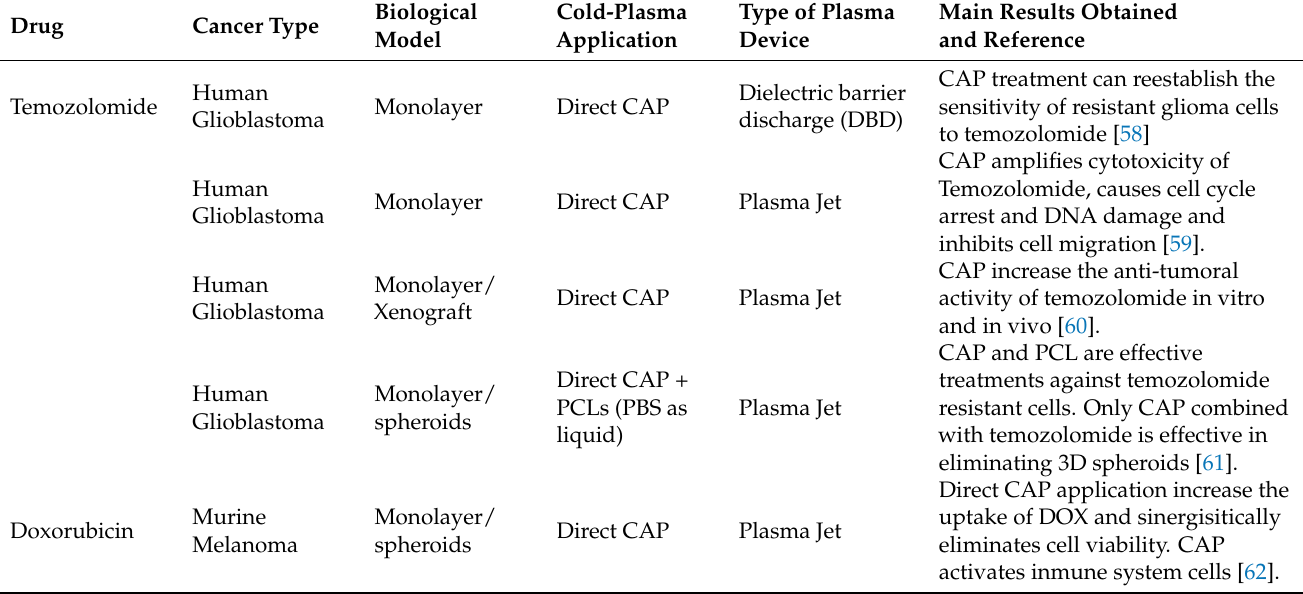
Table 1. List of chemotherapeutic agents studied in combination with CAP or